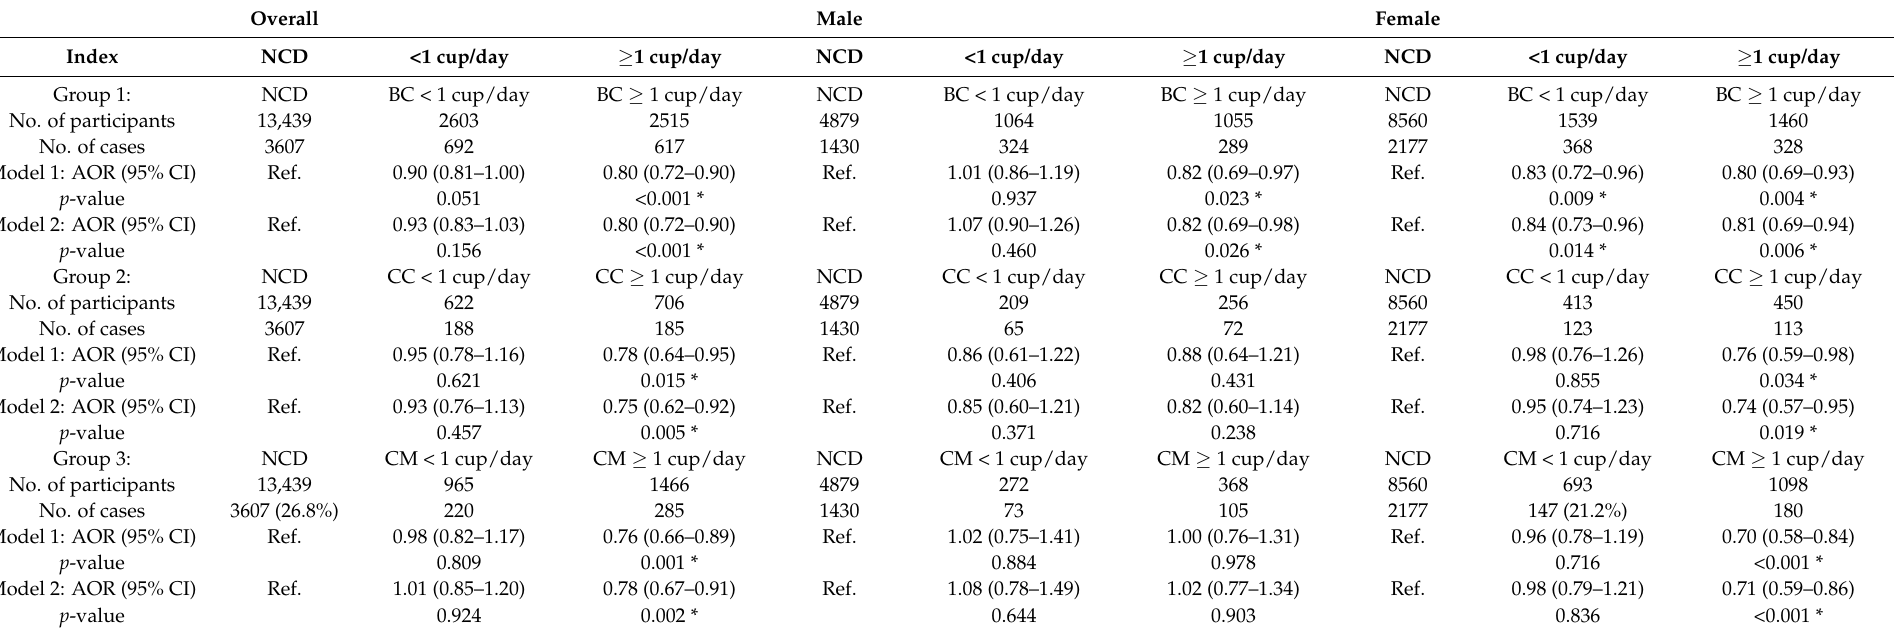
Table 4. The adjusted odds ratio of different daily coffee drinking volume in metabolic syndrome in three coffee types in Taiwanese participants aged 30–79 years. Male